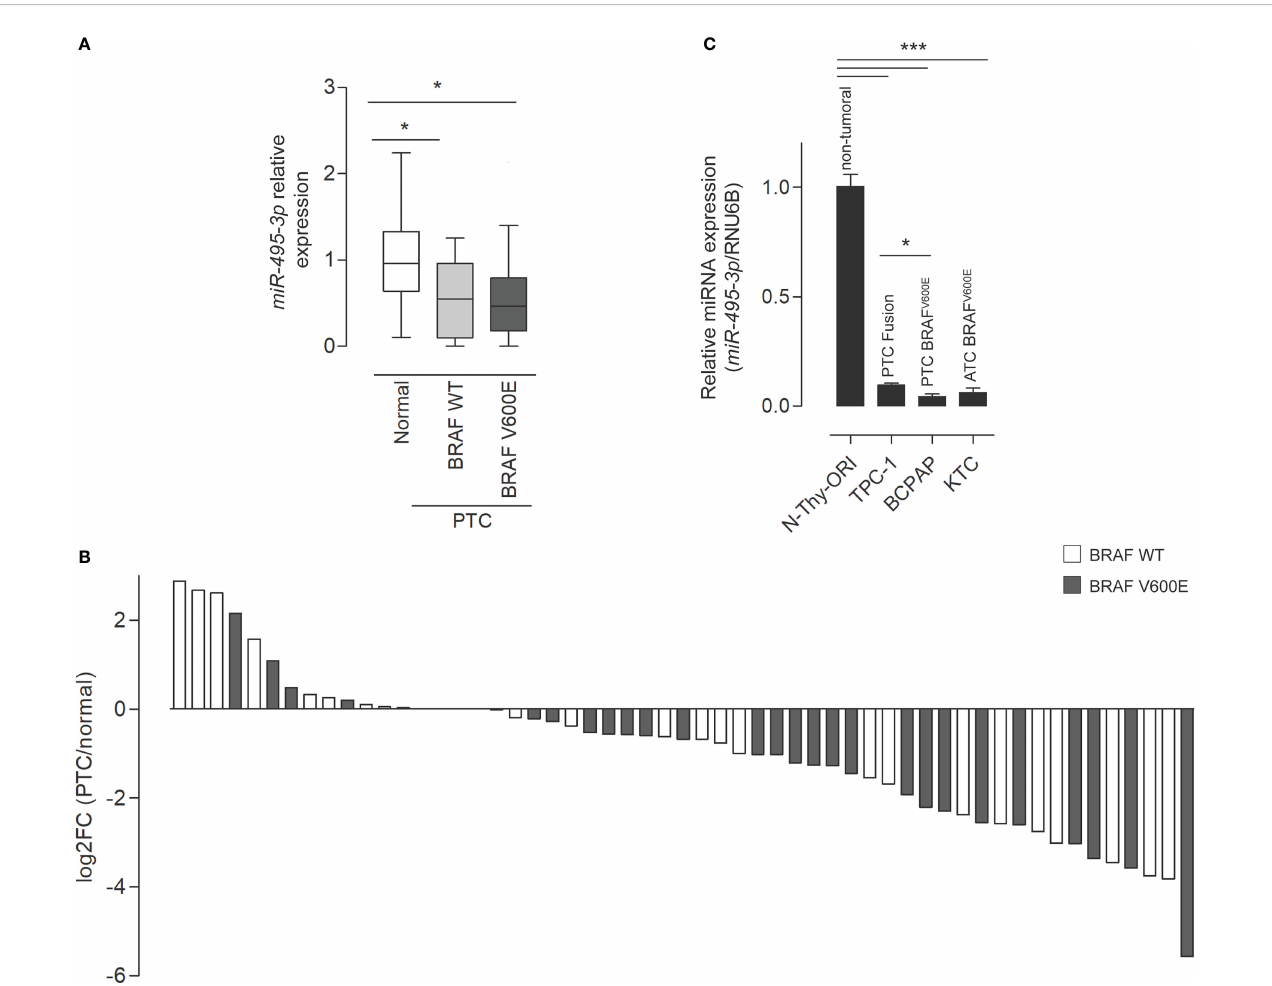
FIGURE 1 miR-495-3p is down regulated in PTC. (A) Boxplot (Whiskers: Tukey) shows the differential expression between normal samples and tumor samples bearing or not the BRAF V600E mutation (individual normalized RPM values/mean of normalized RPM values for the normal group). (B) Waterfall plot for 55 paired tumor/healthy tissue samples analyzing miR-495-3p expression shows that the downregulation of miR-495-3p is a common event during carcinogenesis. Expression data for the plot is from TCGA. Gray bars on the waterfall plot represent BRAF V600E -positive samples and white bars the PTC samples where the mutation is absent. (C) Bar plot shows the expression of miR-495-3p in four different thyroid cell lines. As previously described, the malignant cells have progressive decreases in miR-495-3p expression. Data are presented as the average of triplicates of a single experiment and bars represent the standard errors of the means (SEMs). *P<0.05,